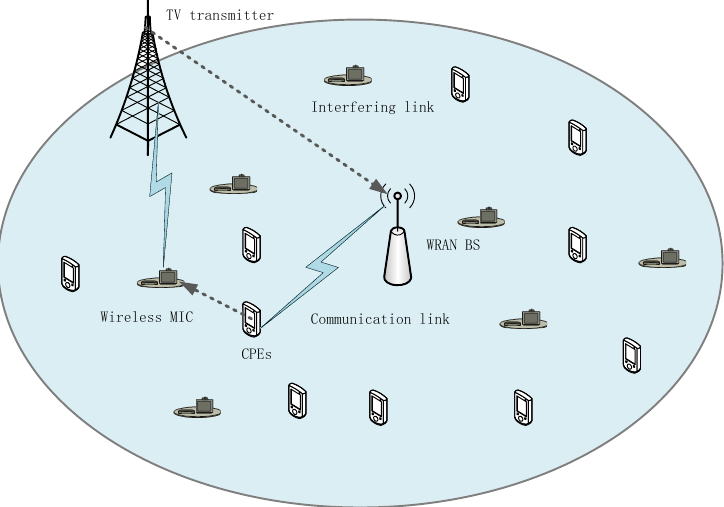
Figure 1. System model